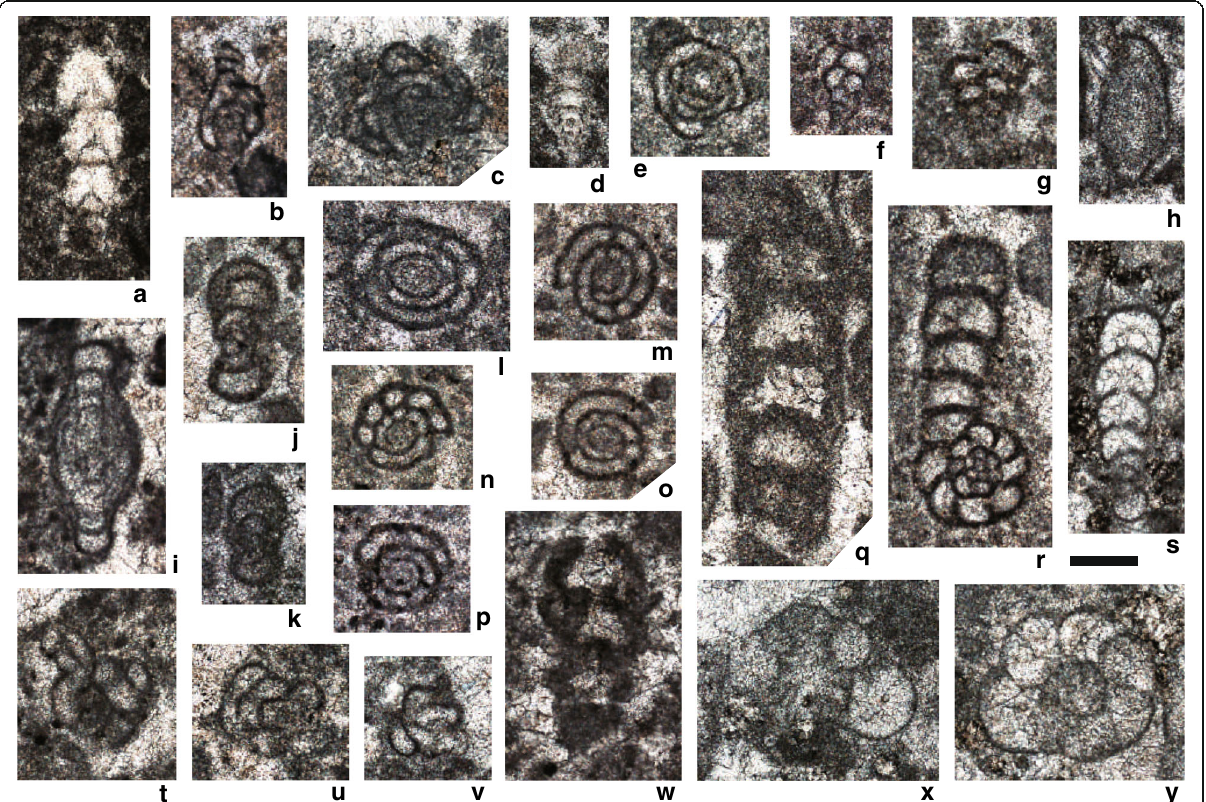
Fig. 5 Photomicrographs of important foraminifers obtained from the studied cores. a Indeterminable nodosariid, sample 4-83; b Pilamminella grandis (Salaj in Salaj et al. 1967), sample 4-34; c Pilammina cf. densa Panti ć 1964, sample 1-3; d Austrocolomia sp., sample 4-136; e Hemigordiellina sp., sample 4-83; f Valvulina cf. azzouzi Salaj 1977, sample 4-79; g Gaudryina sp., sample 4-102; h Indeterminable involutinid ( Aulotortus ?), sample 4-139; i Triadodiscus cf. praecursor (Ga ź dzicki in Ga ź dzicki et al. 1975), sample 4-129; j Endoteba sp. A., sample 4-117; k Endotriada tyrrhenica Vachard et al. 1994, sample 1-14; l – p Citaella dinarica (Kochansky-Devidé and Panti ć 1966), l sample 4-29, m – p sample 4-55; q Earlandinita sp., sample 4-16; r Endotriadella pentacamerata (Salaj in Salaj et al. 1967), sample 4-83; s Endotriadella wirzi (Koehn-Zaninetti 1969), sample 1-82; t – v Citaella ? deformata (Salaj in Salaj et al. 1967), t sample 4-55, u sample 4-29, v sample 4-139; w Ammobaculites ? sp., sample 4-9; x and y indeterminable duostominids (probably Duostomina or Diplotremina ), x sample 1- 14, y sample 1-7. Scale bar, 200 μ m (applicable to all